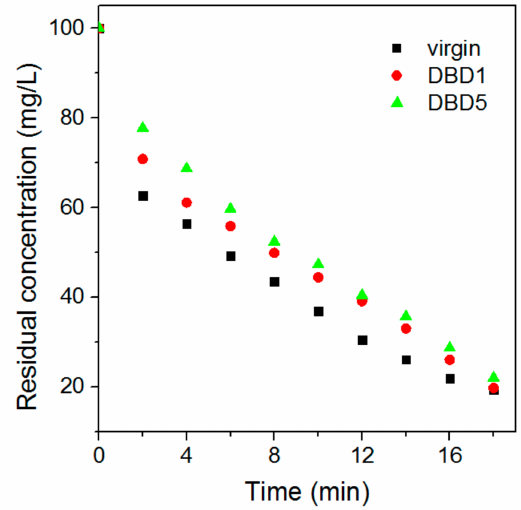
Figure 3. Residual concentration changes of indigo carmine solutions by virgin and different saturated/DBD regeneration